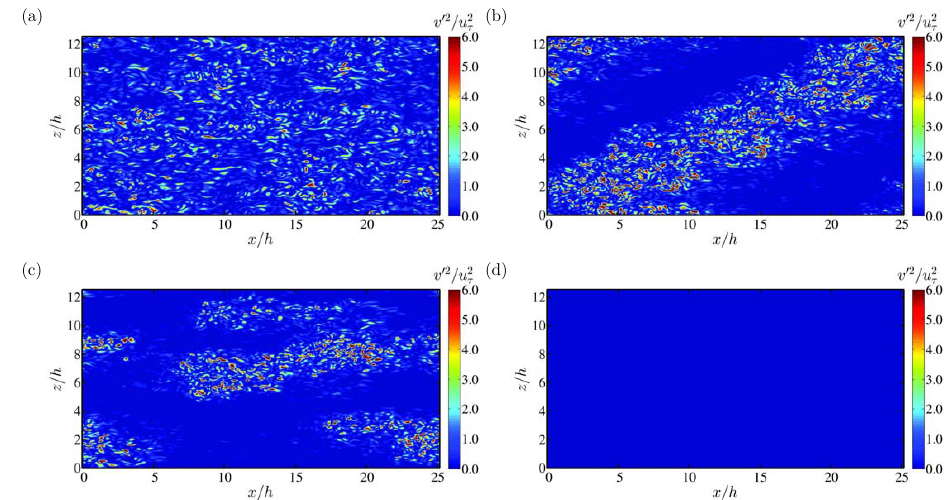
Figure 8. Instantaneous contours of v (cid:48) 2 at a horizontal ( x – z ) plane with different Ri τ ( Re τ = 180). The x – z plane is located at y + = 45 (see Fig. 2 for the definition of the x – z plane). (a) Ri τ = 30, (b) Ri τ = 120, (c) Ri τ = 240, and (d) Ri τ = 480.